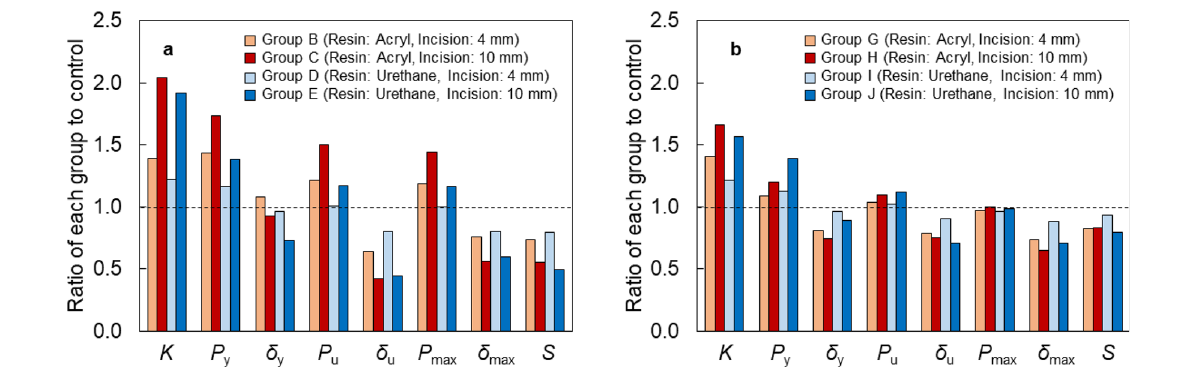
Fig. 11 Ratio for evaluating the strengthening effect calculated by dividing properties of impregnated group by control group. a Groups loaded parallel to the grain. b Groups loaded perpendicular to the